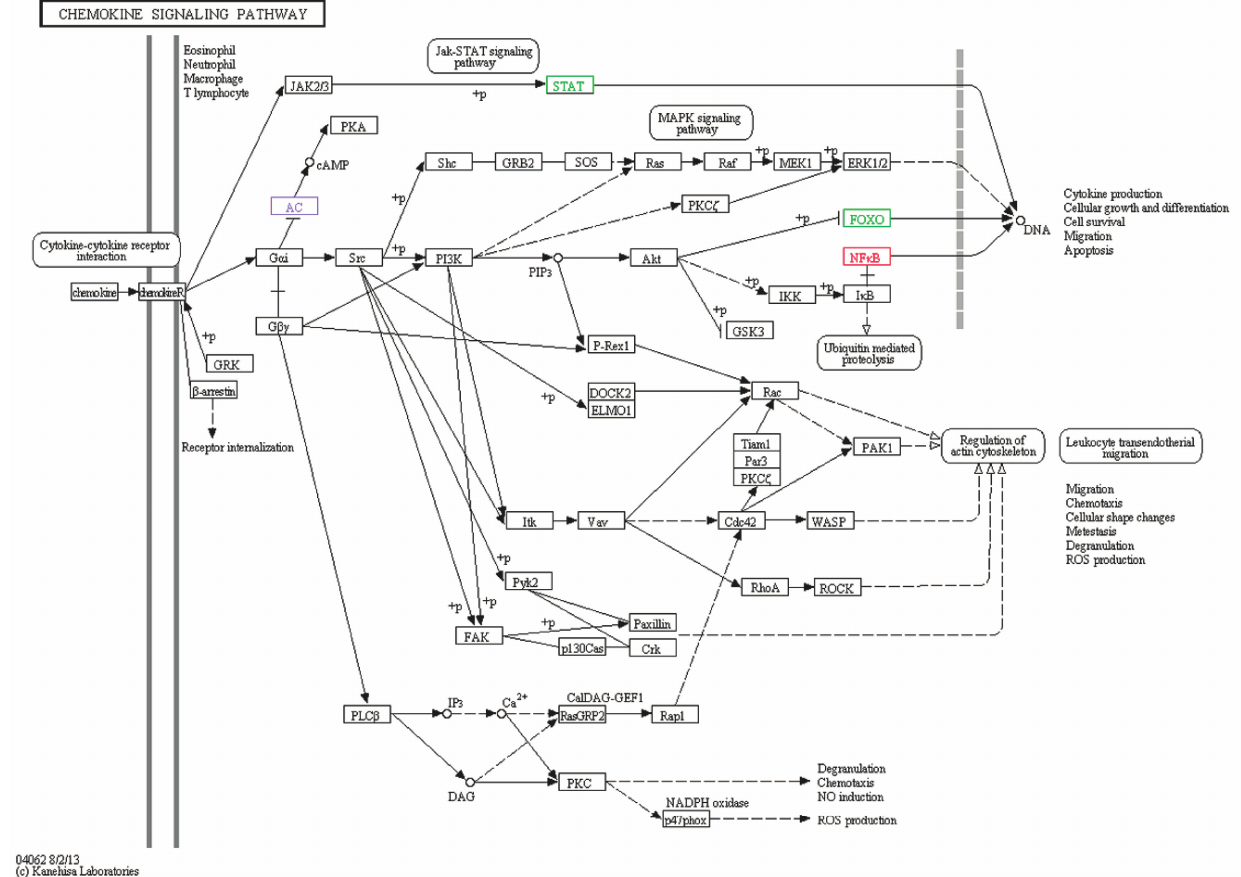
Figure 14. Chemokine signaling pathway. Red boxes represent up-regulated genes, green boxes represent down-regulated genes, and blue box includes two genes of which one is an up-regulated gene and the other is a down-regulated